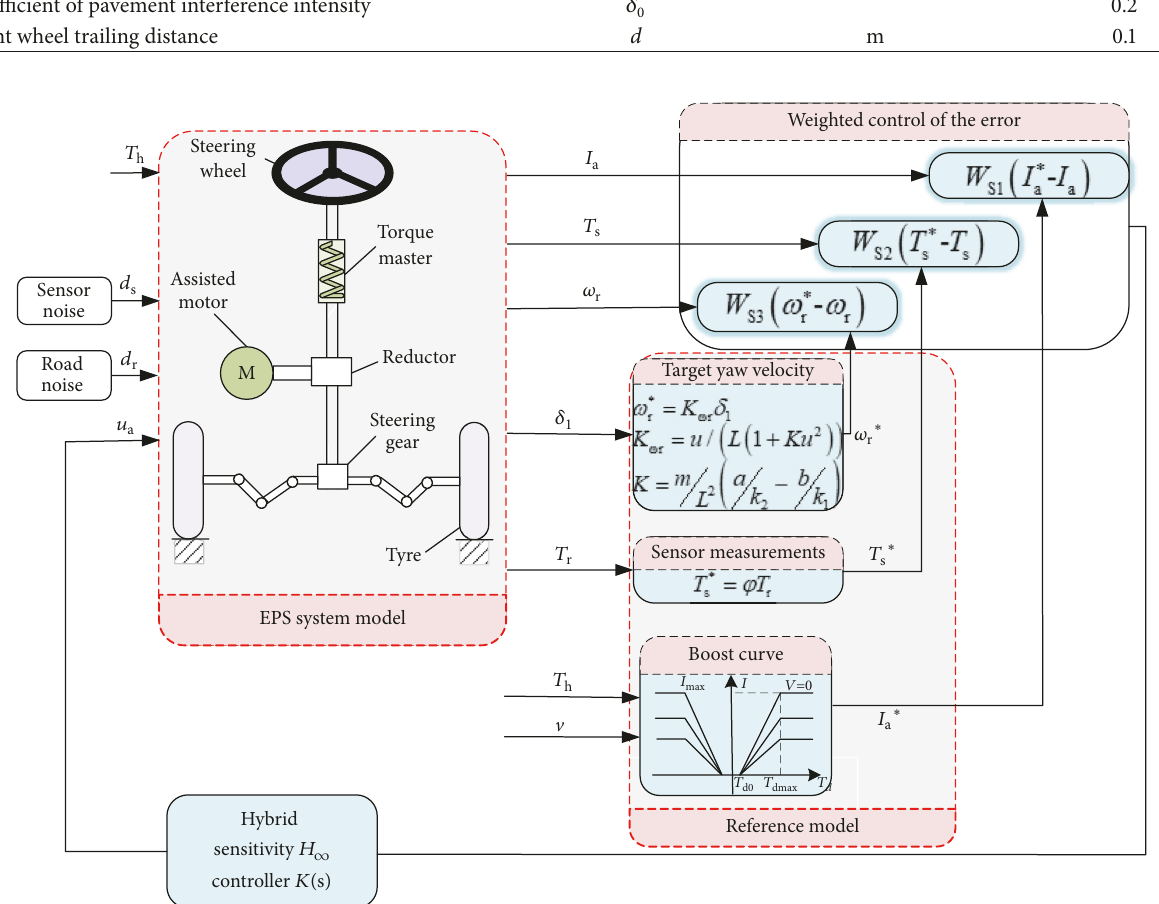
Figure 4: EPS hybrid sensitivity H ∞ control system structure